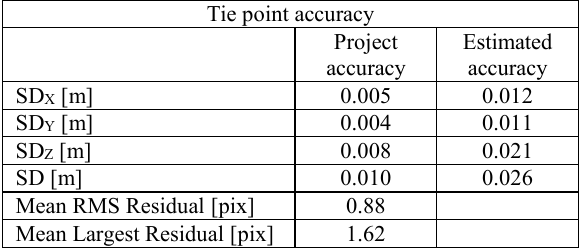
Table 3. Achieved accuracy of tie points of merged projects